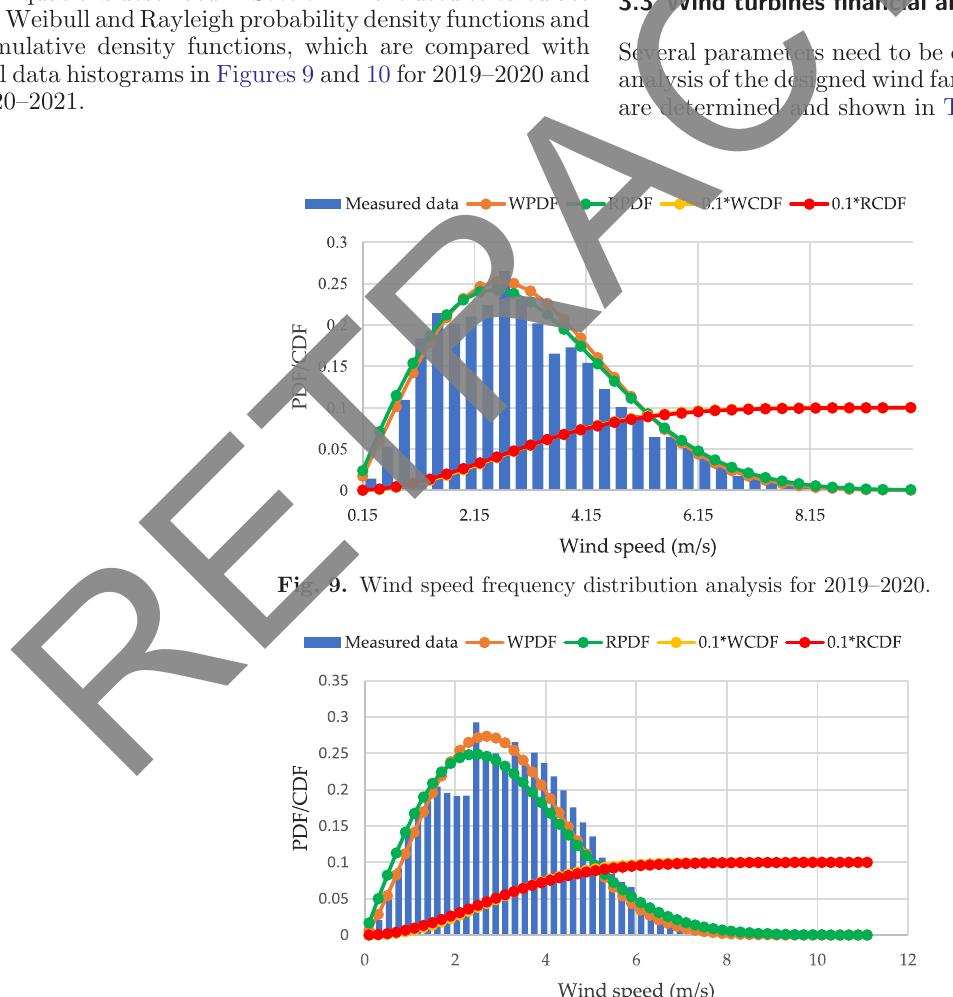
Fig. 10. Wind speed frequency distribution analysis for 2020 –